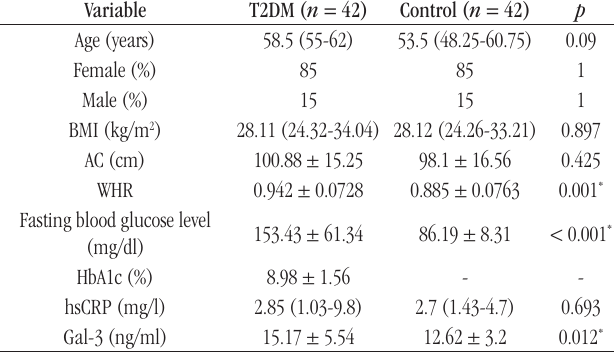
TABLE 1 – Clinical and laboratory parameters in the T2DM with kidney disease group and the control group Variable